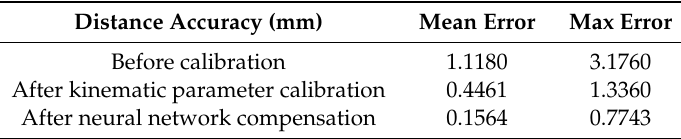
Table 2. Distance accuracy of the